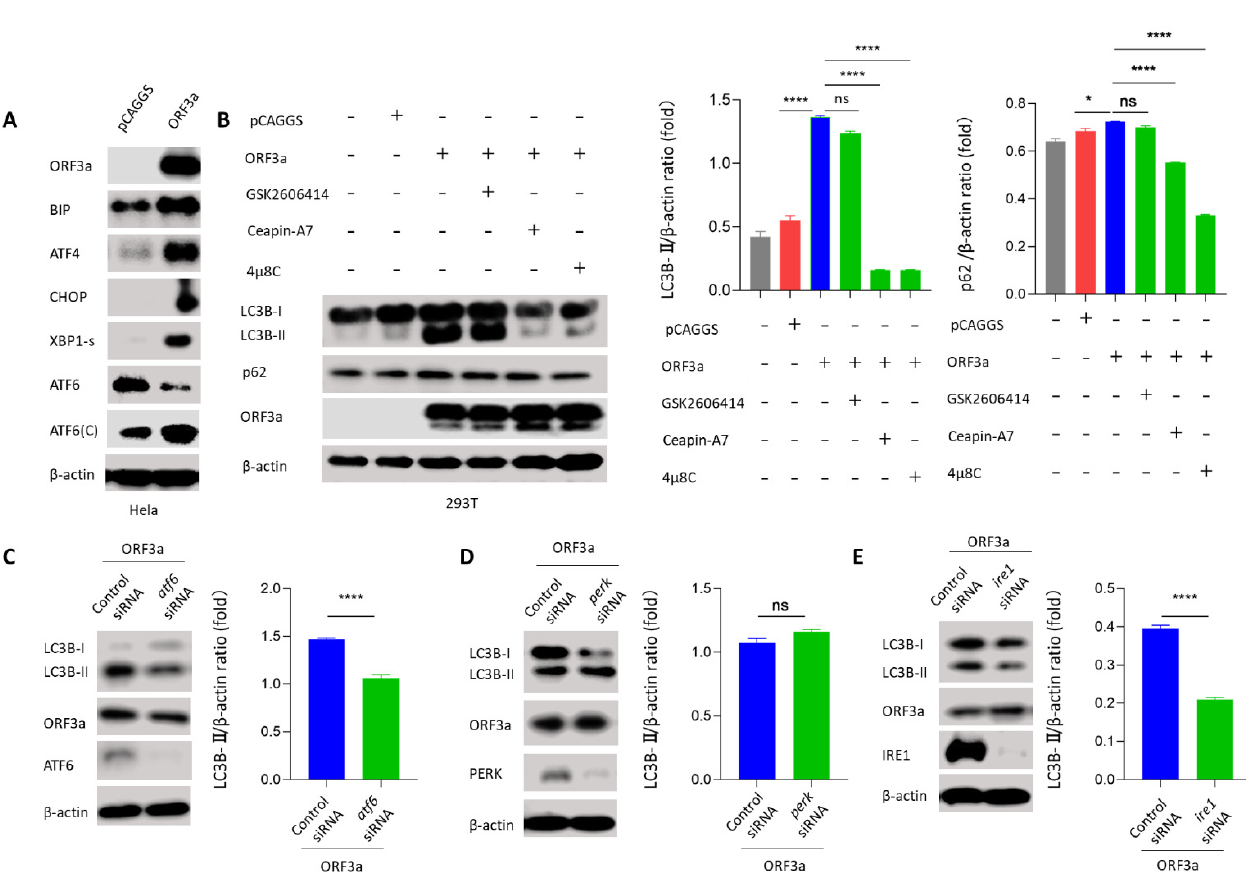
Figure 5. ORF3a induced autophagy through unfolded protein response. ( A ) Hela cells (1–2 × 10 5 cells) were transfected with HA-Tag-ORF3a (2 μ g) or empty vector (2 μ g) for 24 h. Western blot was performed to detect UPR-related proteins. with HA-Tag-ORF3a (2 µ g) or empty vector (2 µ g) for 24 h. Western blot was performed to detect UPR-related